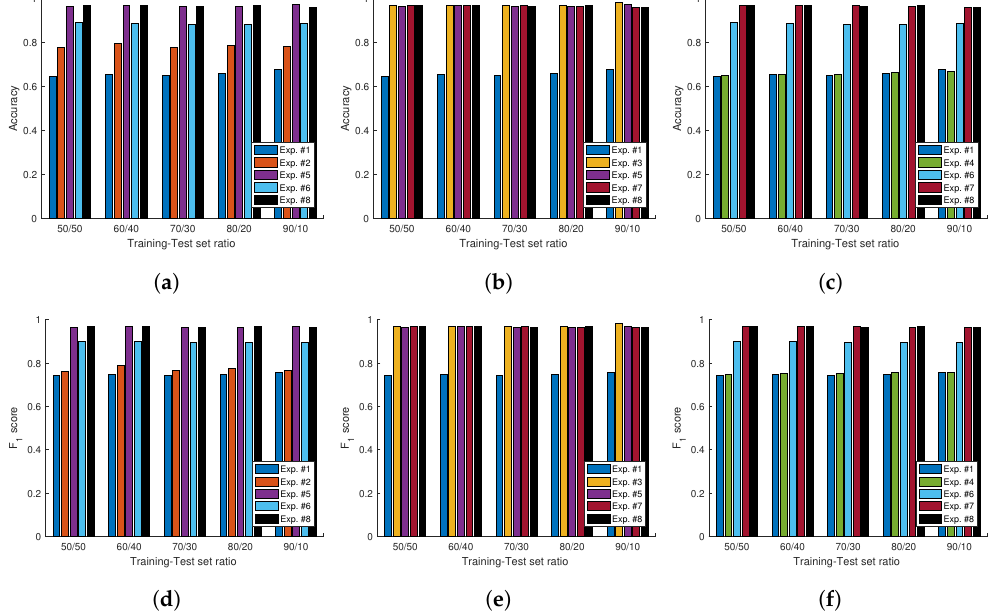
Figure 6. Performance results of the proposed model evaluated by Accuracy (Acc) and F 1 score for the first set of experiments. ( a ) Experiments 1, 2, 5, 6, 8 (Acc). ( b ) Experiments 1, 3, 5, 7, 8